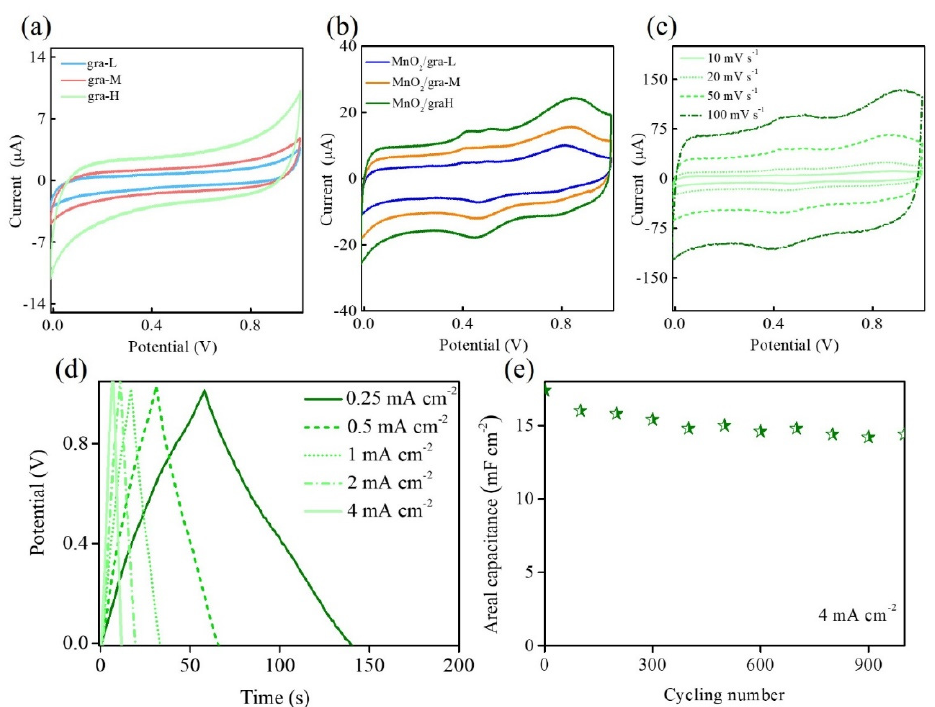
Figure 5. CV curves of ( a ) gra-L, gra-M, and gra-H, and ( b ) MnO 2 /gra-L, MnO 2 /gra-M, and MnO 2 /gra-H in 1 M Na 2 SO 4 at a scan rate of 20 mV s − 1 . ( c ) CV curves of MnO 2 /gra-H in 1 M Na 2 SO 4 at different scan rates. ( d ) Galvanostatic charge/discharge curves of MnO 2 /gra-H in 1 M Na 2 SO 4 at different current densities. ( e ) Cyclic stability of MnO 2 /gra-H in 1 M Na 2 SO 4 is recorded every 100 cycles during cycling (denoted by green star). Table 4. Comparison of the capacitive performance with transition metal-based electrode materials. Electrode Materials